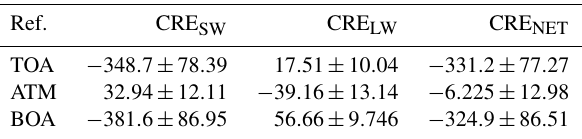
Table 7. Mean and standard deviation of modeled CREs (Wm − 2 ) for the SW, LW, and NET (SW plus LW) radiation for the reference simulation over all case days. ATM stands for the atmospheric cloud radiative effect, defined as the difference between the CREs at the TOA and BOA.